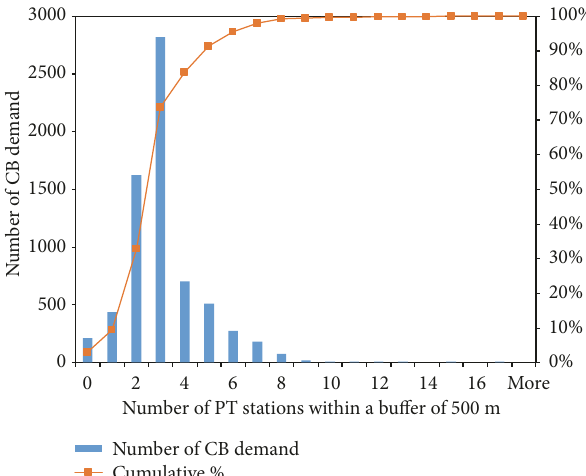
Figure 8: Number of PT stations within 500 m of each CB demand